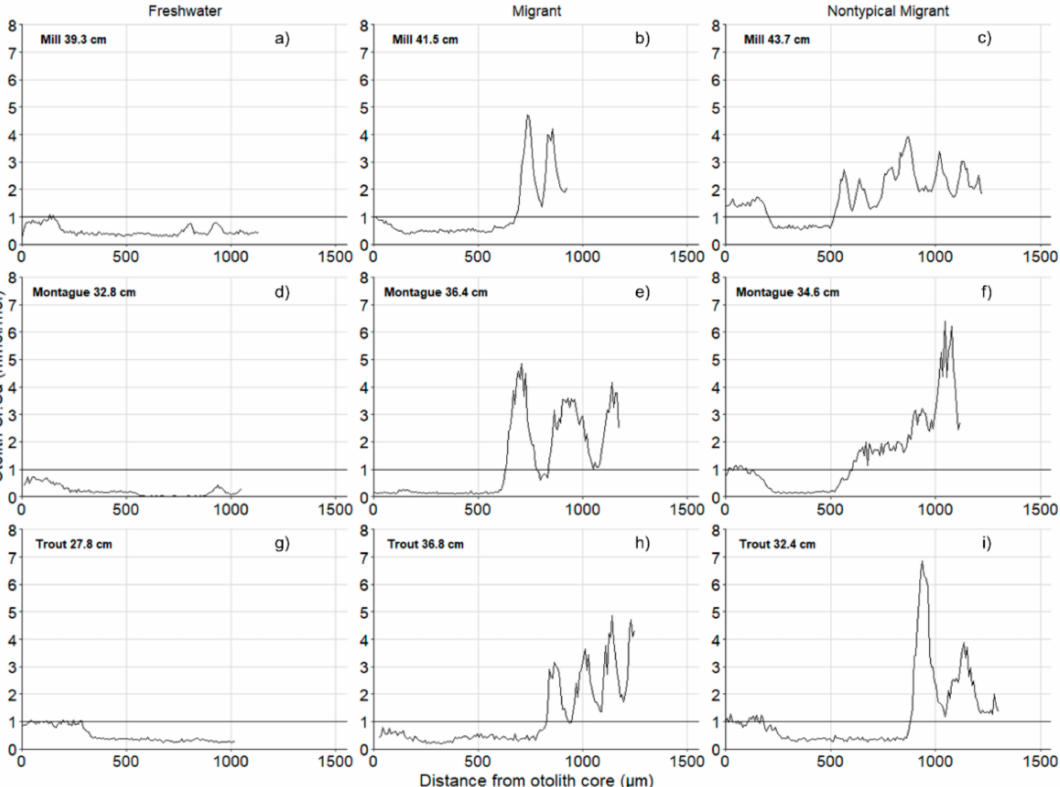
Figure 4. Representative otolith microchemistry line scans for freshwater ( a,d,g ), migrant ( b,e,h ) and nontypical migrant ( c,f,i ) life histories from Mill, Montague and Trout River. Horizontal line shows threshold for determination of anadromous migratory strategy. Size of fish reported in fork length